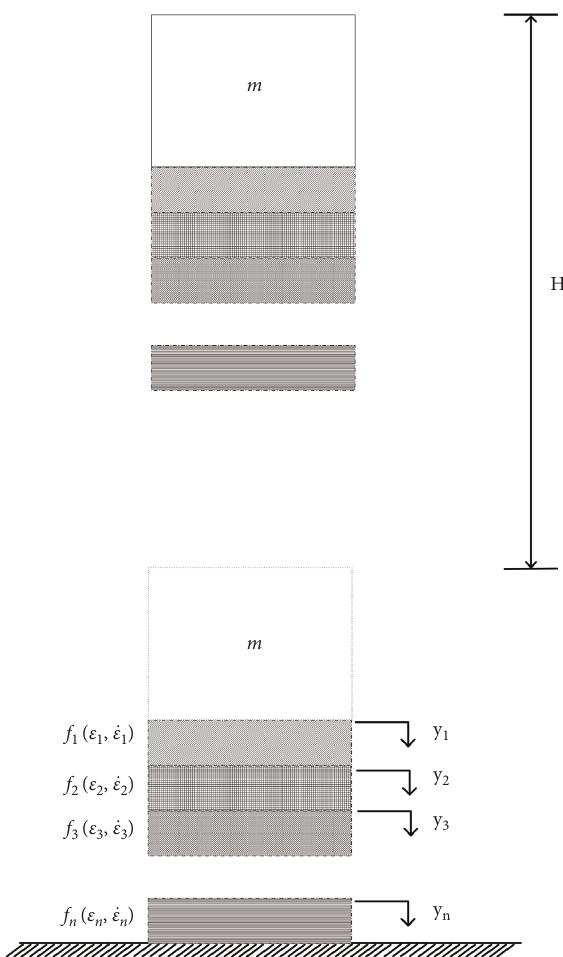
Figure 1: Schematic of series cushioning packaging